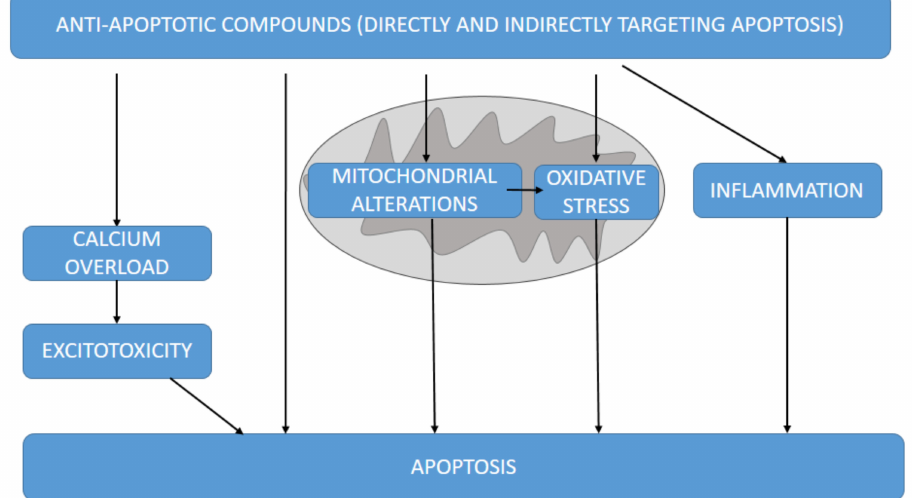
Figure 3. Different mechanisms by which the anti-apoptotic molecules herein discussed could target apoptosis, directly or indirectly through excitotoxicity, mitochondrial alterations and derived oxidative stress and